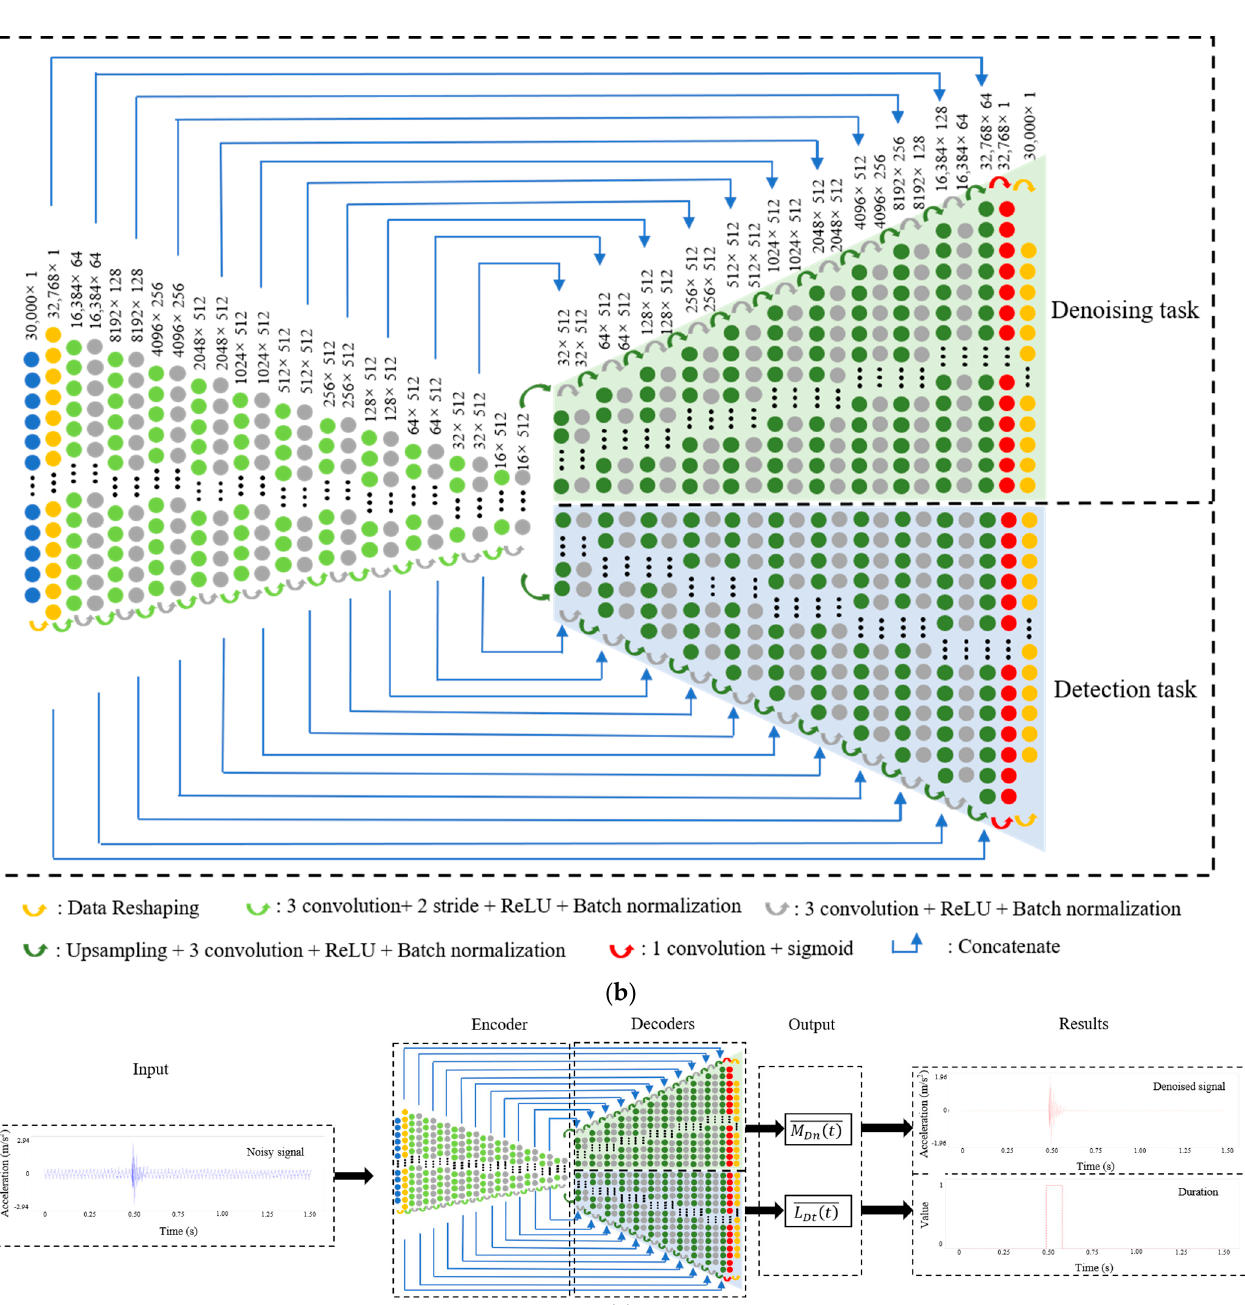
Figure 1. ( a ) Schematic of PDTN. ( b ) Structure diagram of PDTN. Encoder on the left; two decoders on the right; and denoising and detection networks on the top and bottom, respectively. The circles of different colors represent the neural network layer. The arrows represent operations performed between two adjacent layers. The dimensions of each layer are marked as ‘feature × filters’. The encoder performs 11 downsamplings and the two decoders perform 11 upsamplings. The total number of trainable parameters is 47,791,298. ( c ) Flow chart of PDTN for denoising and detection.